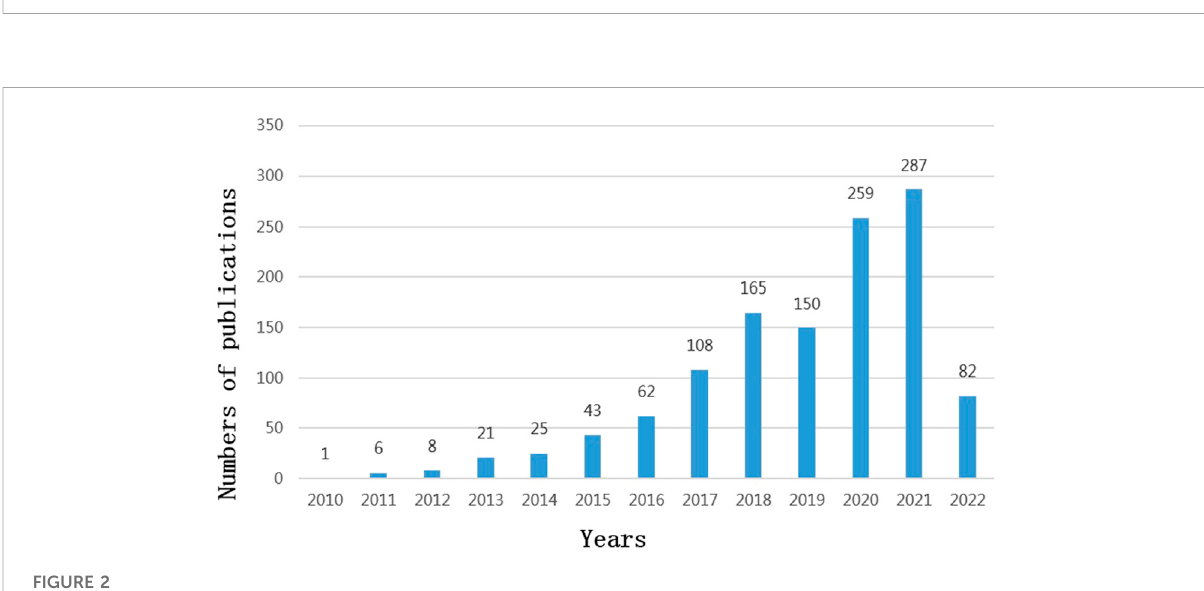
FIGURE 2 Publications over time (2010 –